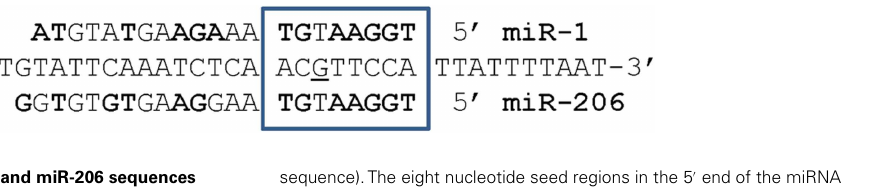
FIGURE 2 |Alignments of the ovine miR-1 and miR-206 sequences with the region in the 3 (cid:48) UTR of wild type ovine MSTN where the c. ∗ 1232 G > A mutation (underlined) occurs. Bolded nucleotides show complementarity of miR-1 and miR-206 with the MSTN 3 (cid:48) UTR (center